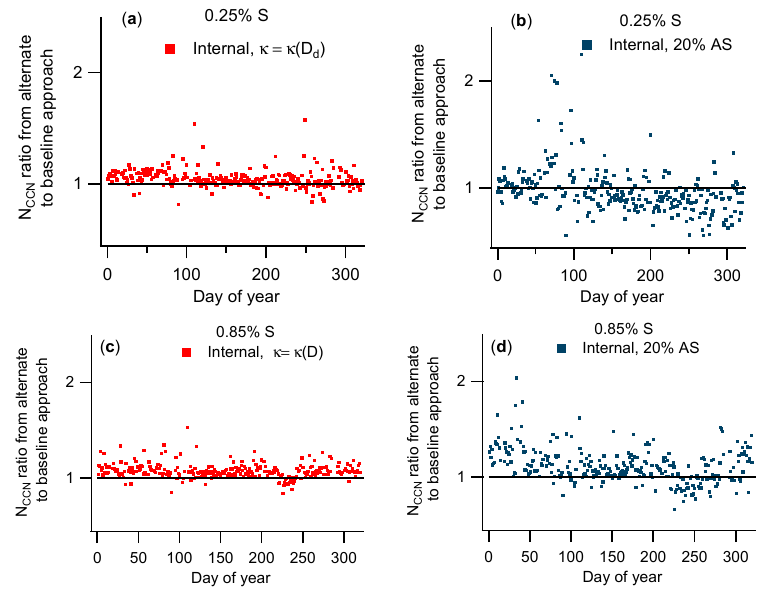
Figure 11. Time series for 2011 of estimated N CCN relative to that from the baseline approach: ( a ) internal mixture, κ = κ (D) at 0.25% S, ( b ) internal mixture, 20% AS at 0.25% S ( c ) internal mixture, κ = κ (D) at 0.85% S, and ( d ) internal mixture, 20% AS at 0.85% S.